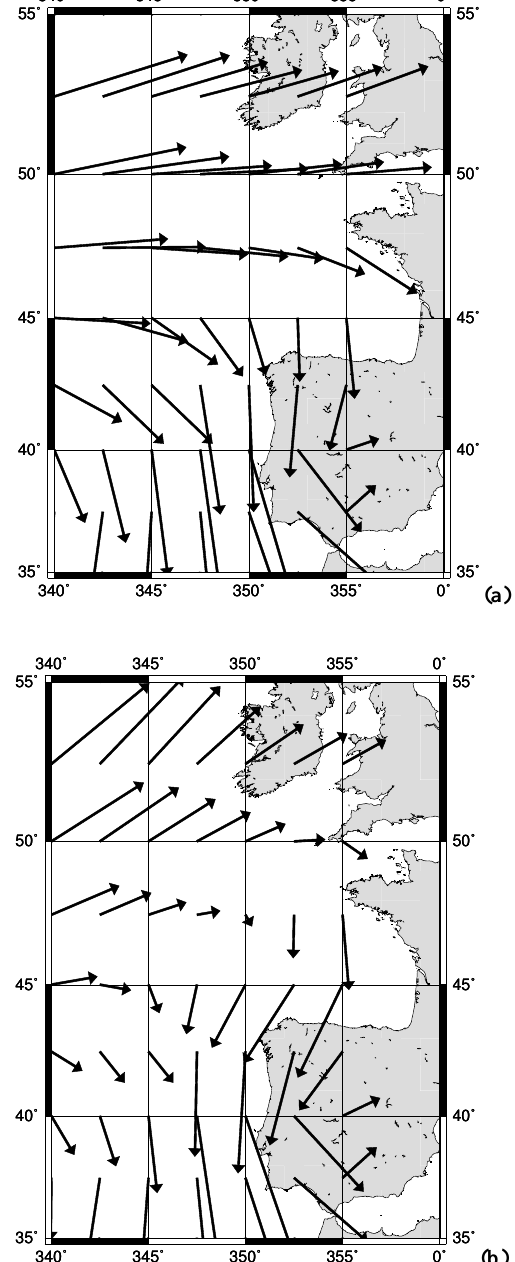
Fig. 6. Dominant winds – Winter. (a) Long-term average 1948– 2001, (b) 1975–1976.